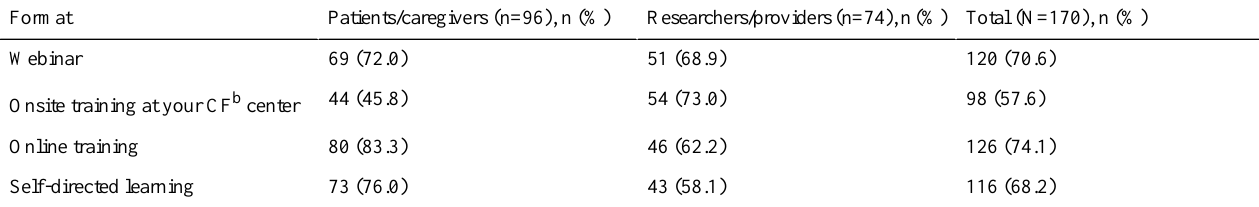
Table 3. Session format preferences a